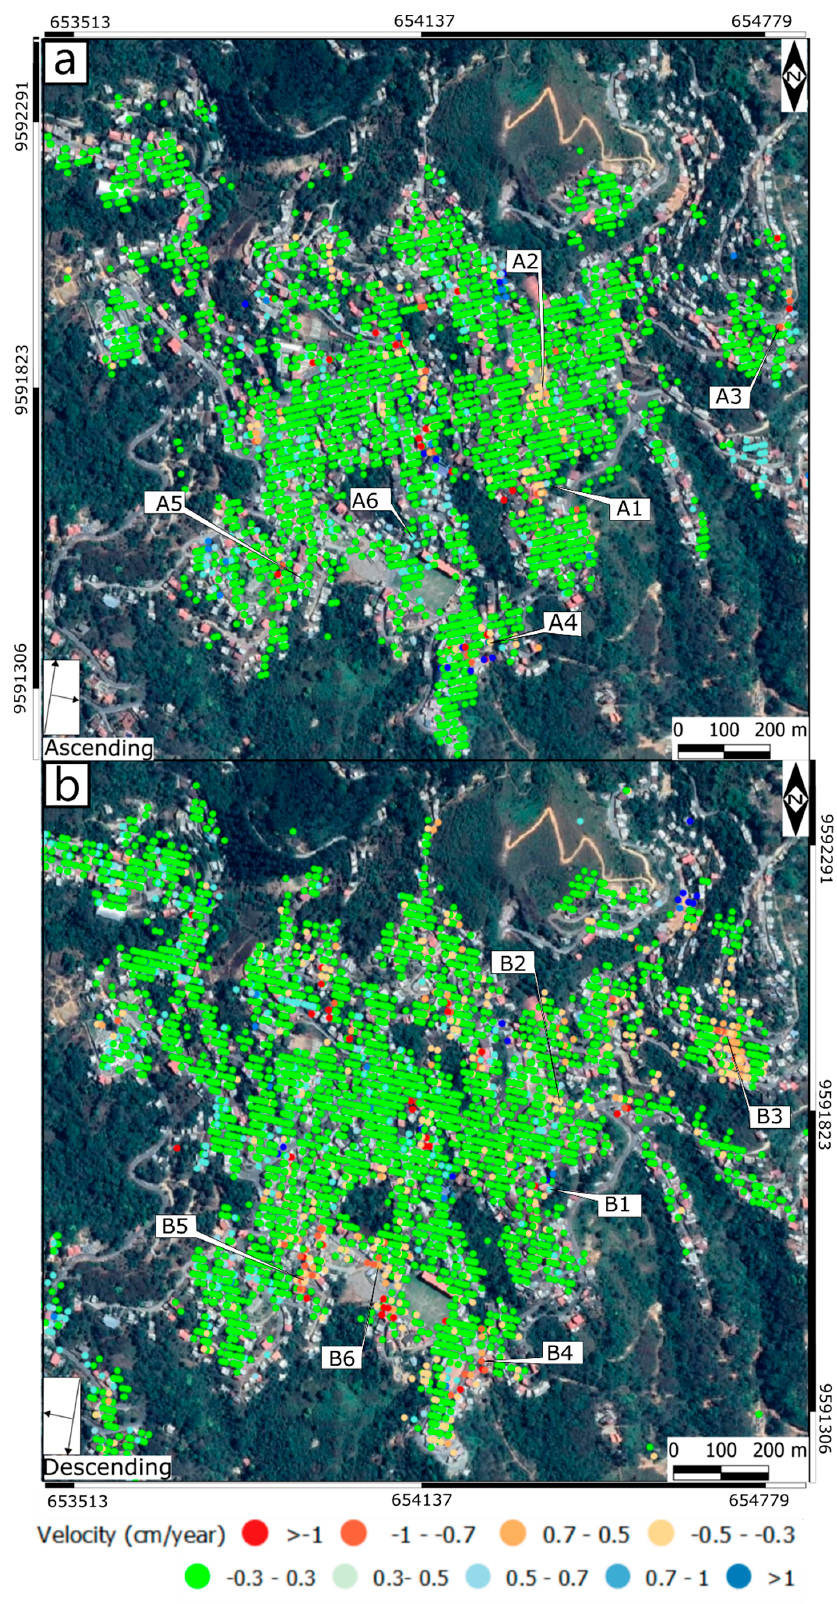
Figure 6. Mean displacement rate map: ( a ) ascending orbit; ( b ) descending orbit. A1–6 and D1–6, ascending and descending, respectively, are points for which vertical and horizontal components have been calculated (see Discussion section).